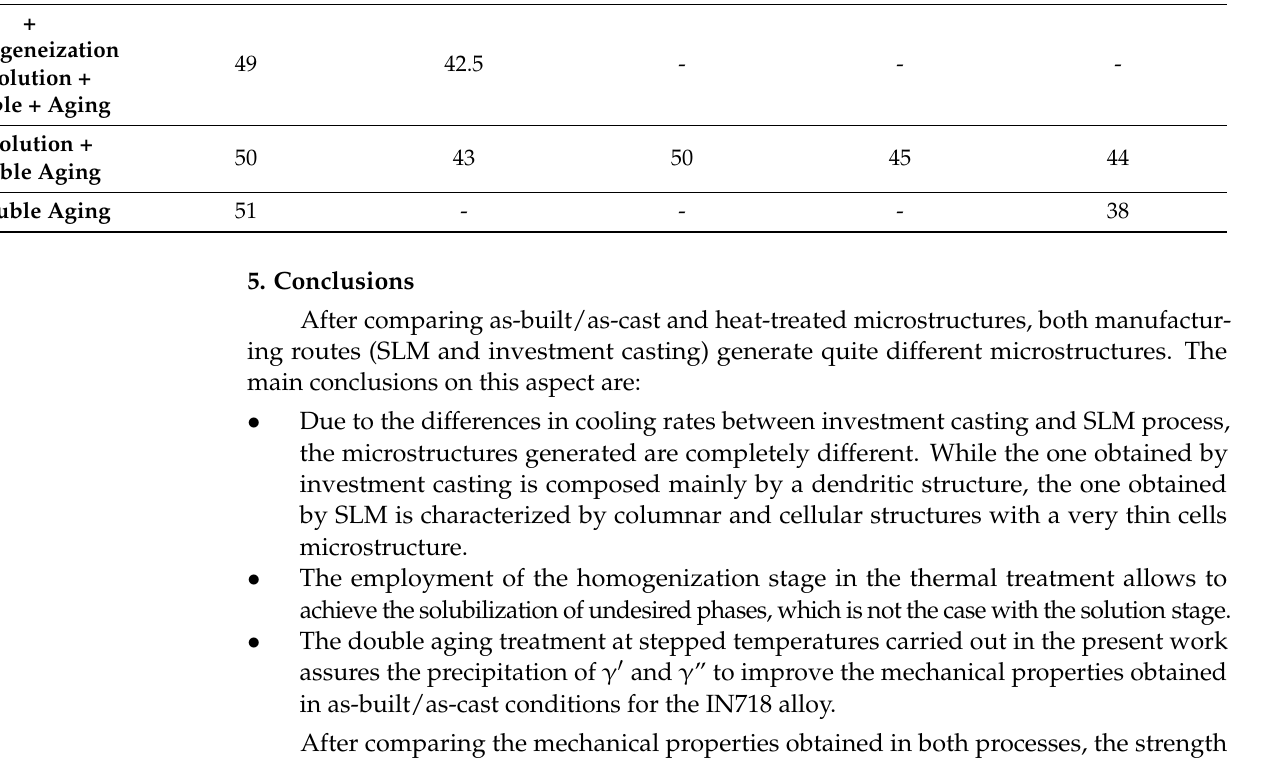
HV0.5 measurements on SLM Y -axis samples) compared to other authors.